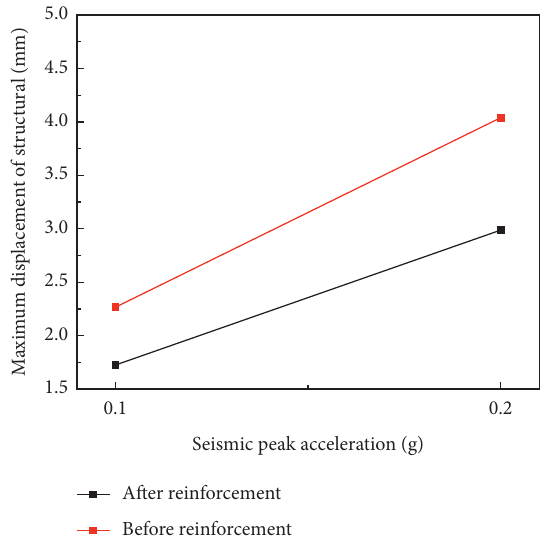
After reinforcement Before reinforcement Figure 19: Comparison of the maximum displacement of the structure under the Loma Prieta earthquake.